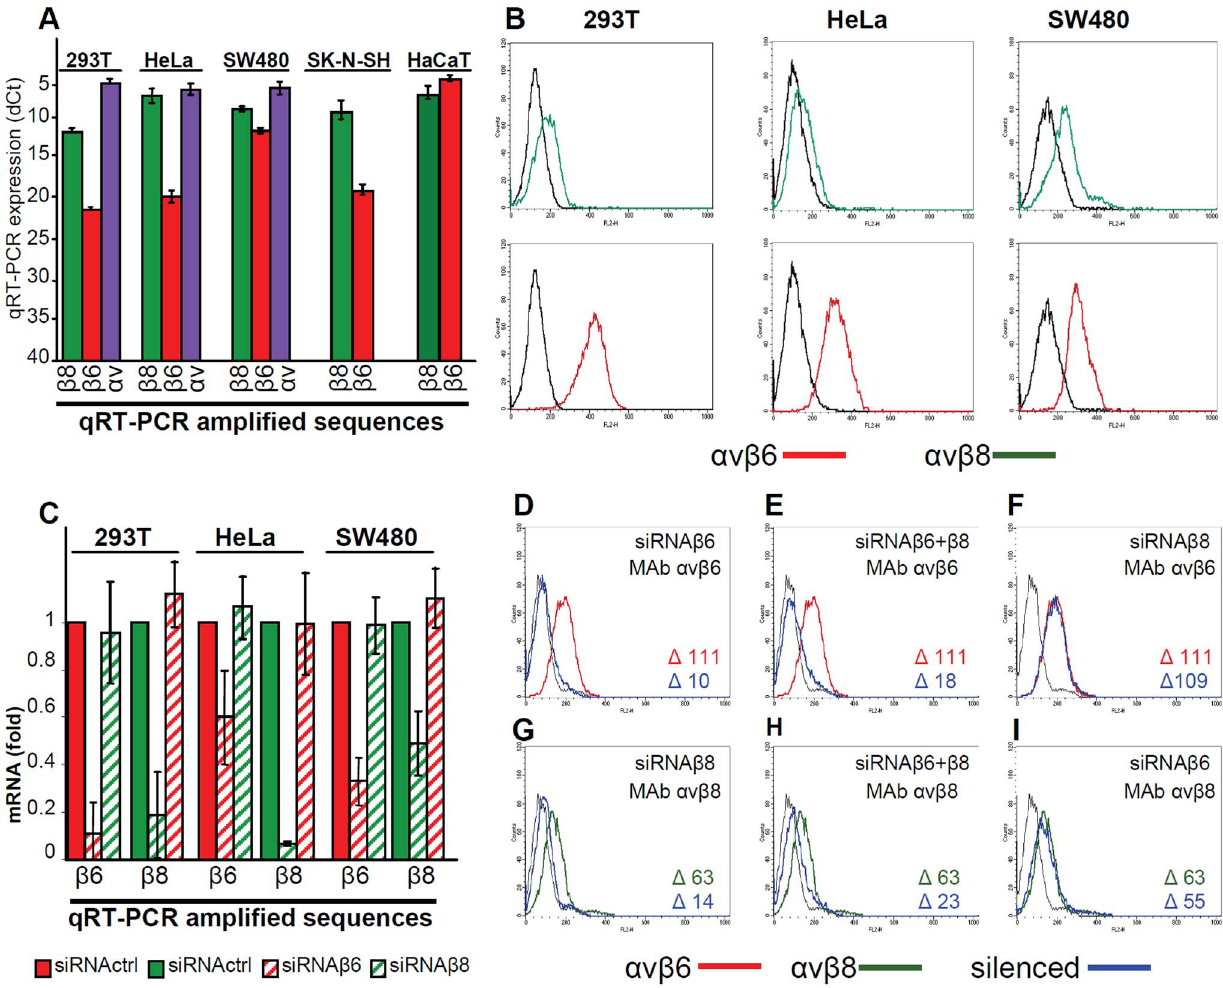
Figure 2. Expression of a v b 6- and a v b 8-integrins in epithelial 293T, HeLa, SW480, SK-N-SH and HaCaT cell lines and silencing by siRNA. (A) q-RT-PCR quantification of a v- (blue), b 6- (red) and b 8- (green) integrin subunits in 293T, HeLa, SW480, SK-N-SH and HaCaT cells. Results are expressedasdCt,relative to GAPDH (Glyceraldehyde 3-phosphate dehydrogenase).Of note, thelowerthedCt value,thehigher the extentof expression. (B) Expression of a v b 6- (red) and a v b 8 (green) -integrin as detected by flow cytometry. The indicated cells were reacted with MAb to a v b 6 or a v b 8- integrins. Abscissa, fluorescence intensity. (C–I) Relative change in b 6- and b 8-integrin expression between control mock-silenced cells (siRNActrl) and cells silenced for b 6- or b 8–integrins (named siRNA b 6 and siRNA b 8 respectively) (C) Expression was determined by q-RT-PCR by means of the 2 2 DD Ct method. The fold expression in siRNActrl cells was made equal to 1. (D–I) Flow cytometry determination of a v b 6 (red) and a v b 8 (green) –integrin expression in mock-silenced (siRNActrl), or silenced for b 6- (D, I), b 8- (F, G), or b 6-plus b 8- (E, H) integrins 293T cells. The integrin-silenced cells are in blue. The figures within each panel refer to difference ( D ) in fluorescence intensity of the stained cells and unspecific fluorescence (black line).